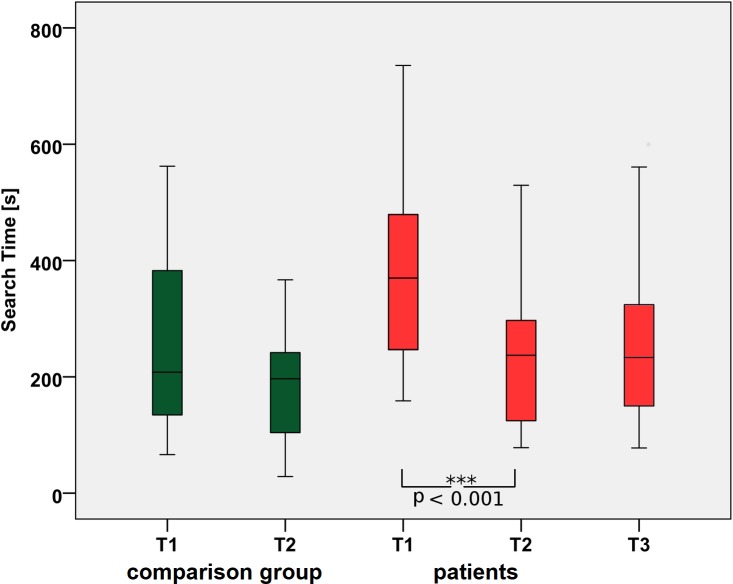
Search performance during eye tracking.Improvement of STs from T1 to T2: The effects are maintained at T3, which supports the hypothesis that the newly learned strategies persist because they keep being used in everyday life.